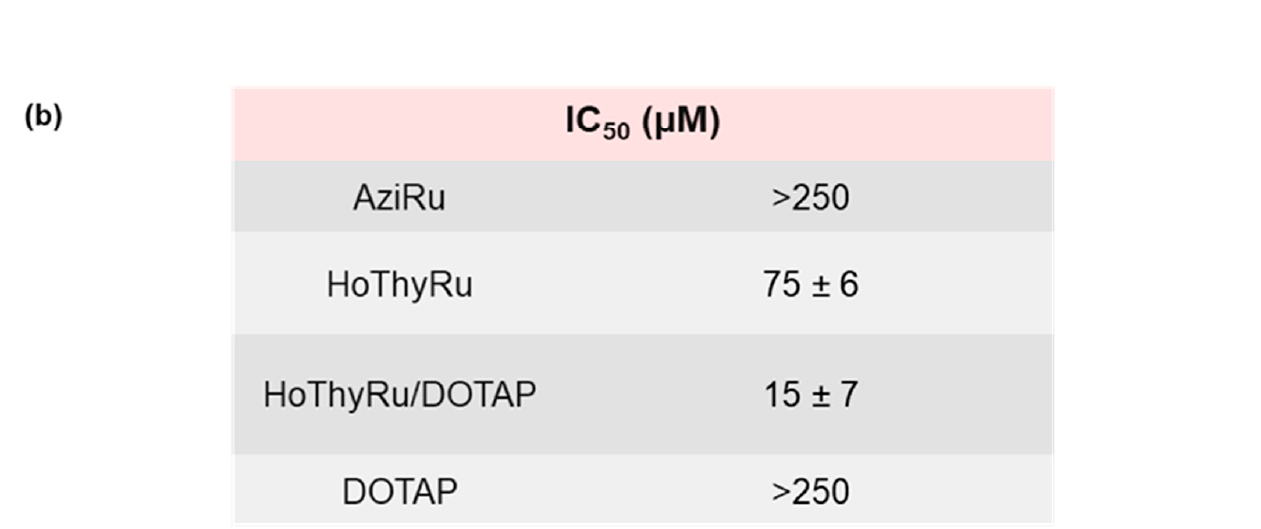
Figure A2. ( a ) Cell survival index, evaluated by the MTT assay and the analysis of the live/dead cell ratio for human